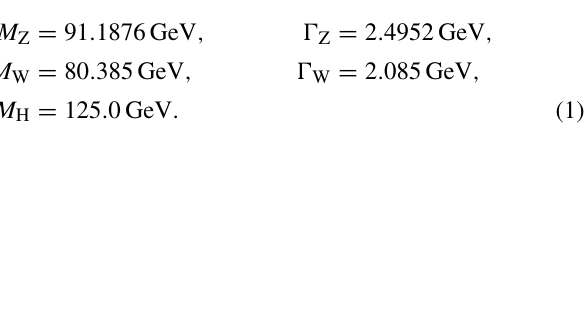
using the POWHEG-BOX matched with HERWIG7 and PYTHIA8 using two different recoil schemes. No hadronisation effects are taken into